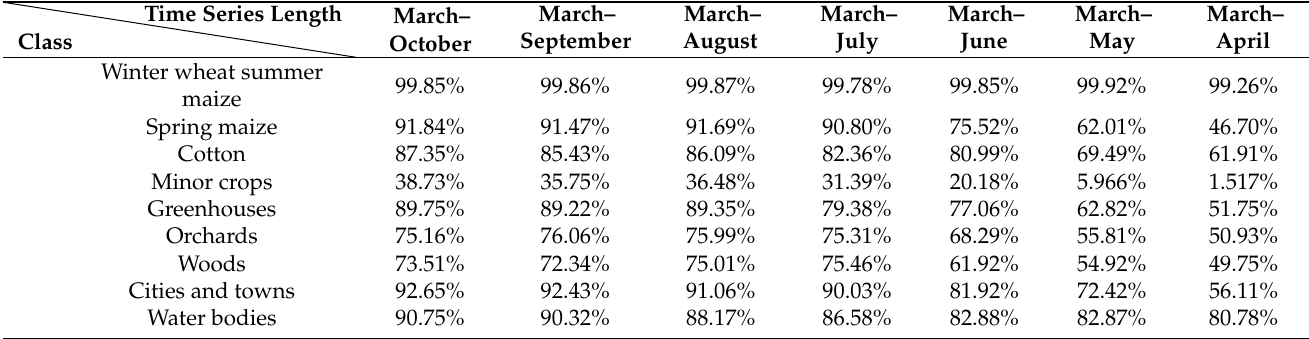
Table A4. Crop identification accuracy of different length NDRE time series in